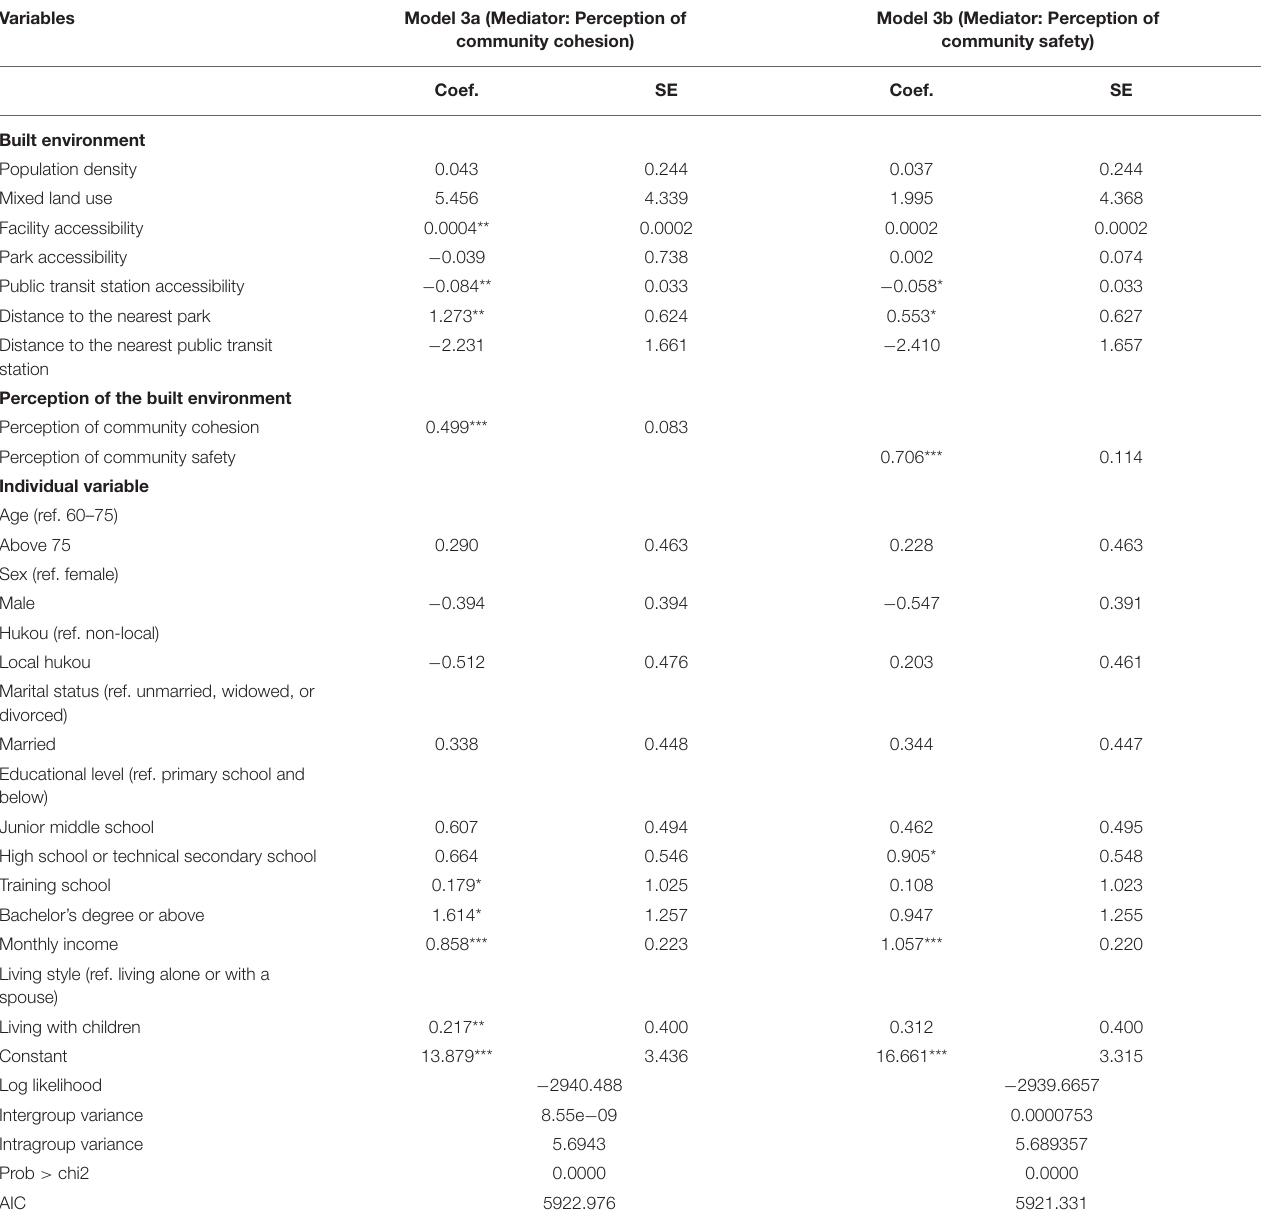
TABLE 5 | Mediation effect of two mediators: perception of community cohesion and perception of community safety.